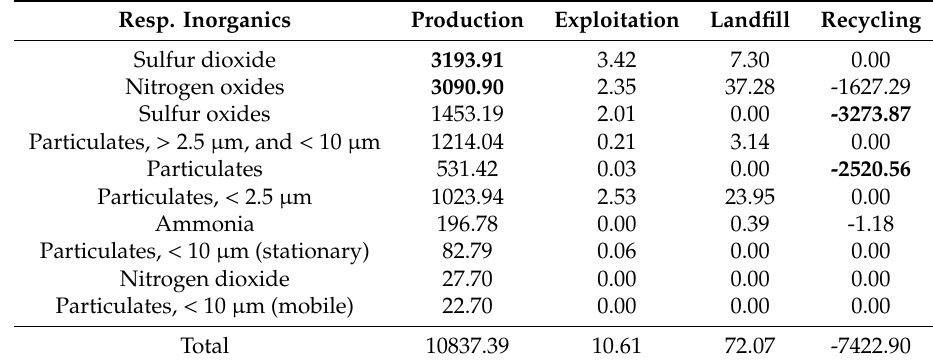
Table 6. Results of grouping and weighting of environmental after-e ff ects for inorganic compounds causing respiratory diseases, occurring in the 1 megawatt photovoltaic power plant [unit: